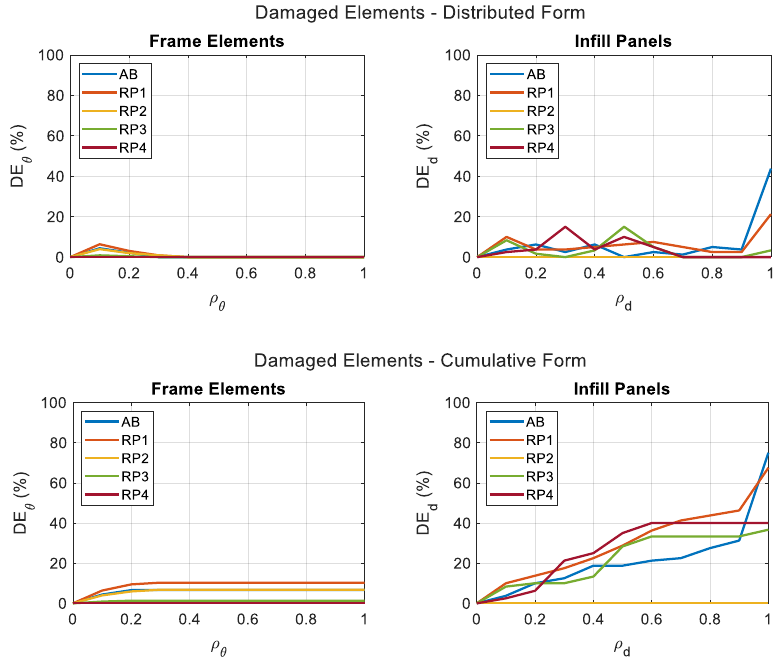
Figure 26. DE in distributed and cumulative forms for AB and RPs configurations.